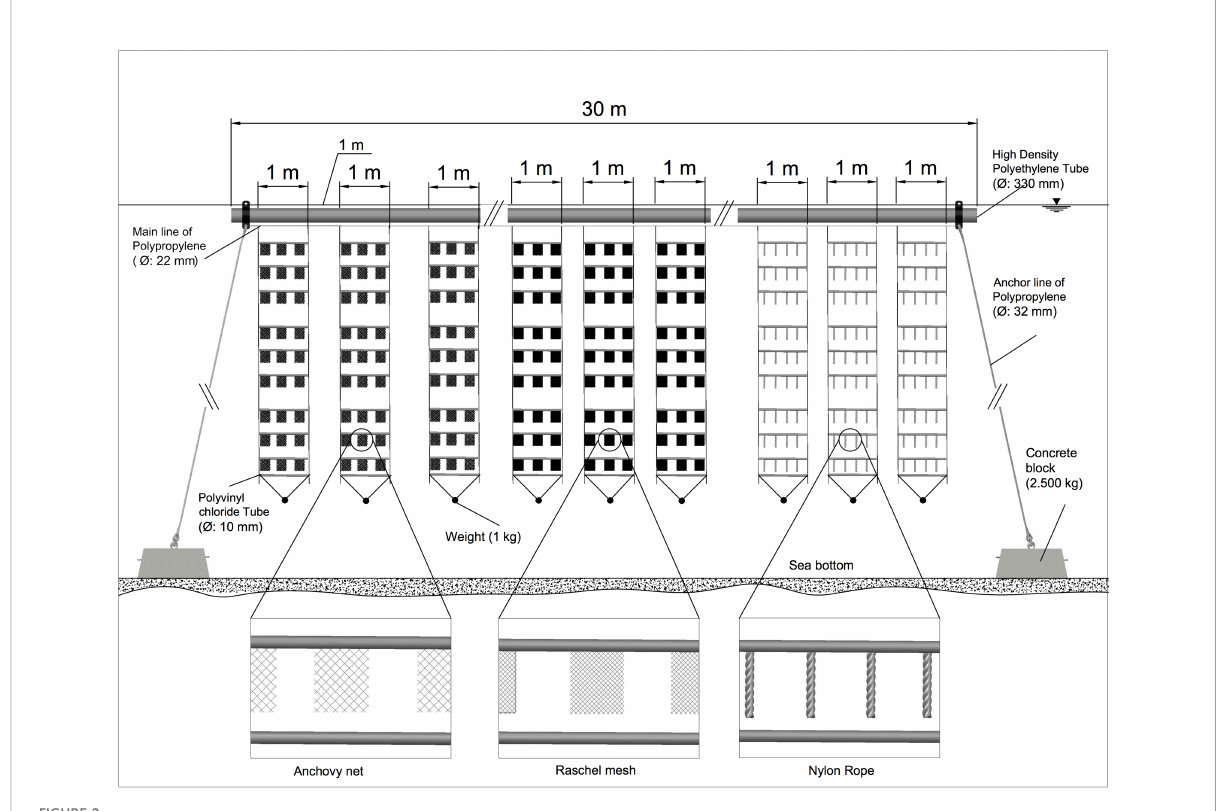
FIGURE 2 Longline system with different spat